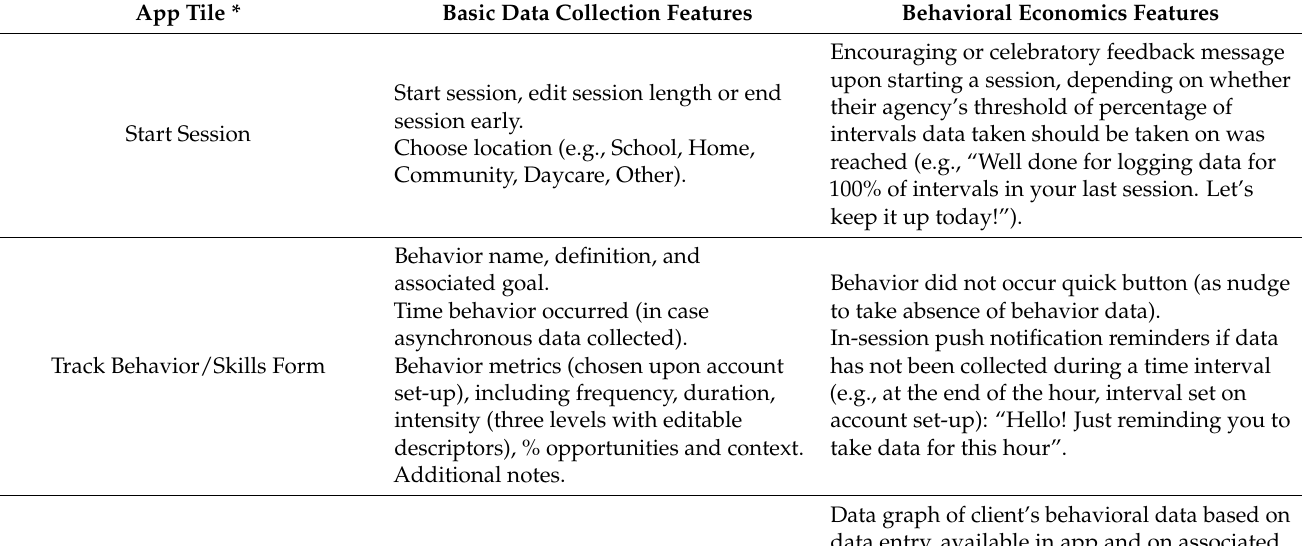
Table 2. Footsteps app: basic data collection and behavioral economics